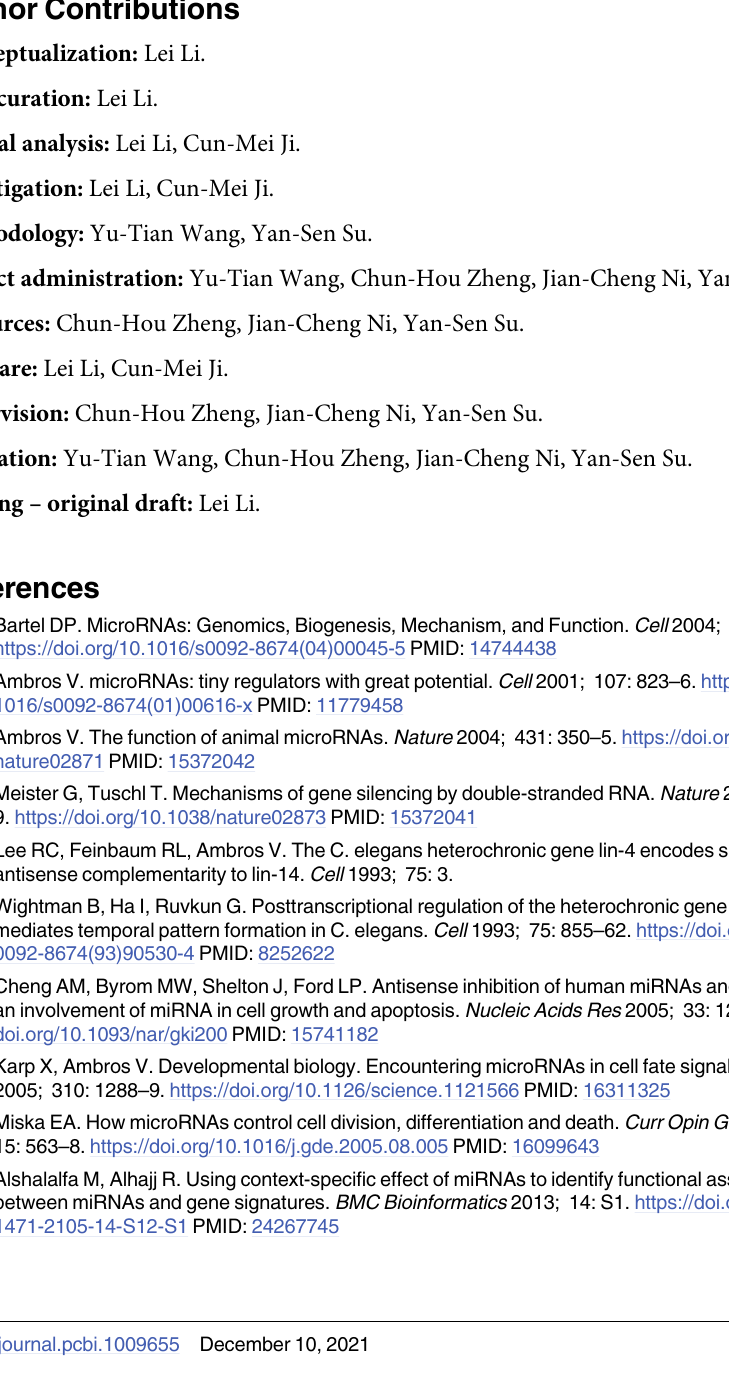
S3 Table. Names of 591 diseases involved in known human miRNA-disease associations obtained from HMDD v3.2 database. S4 Table. The constructed miRNA sequence similarity score matrix. S5 Table. The constructed disease semantic similarity score